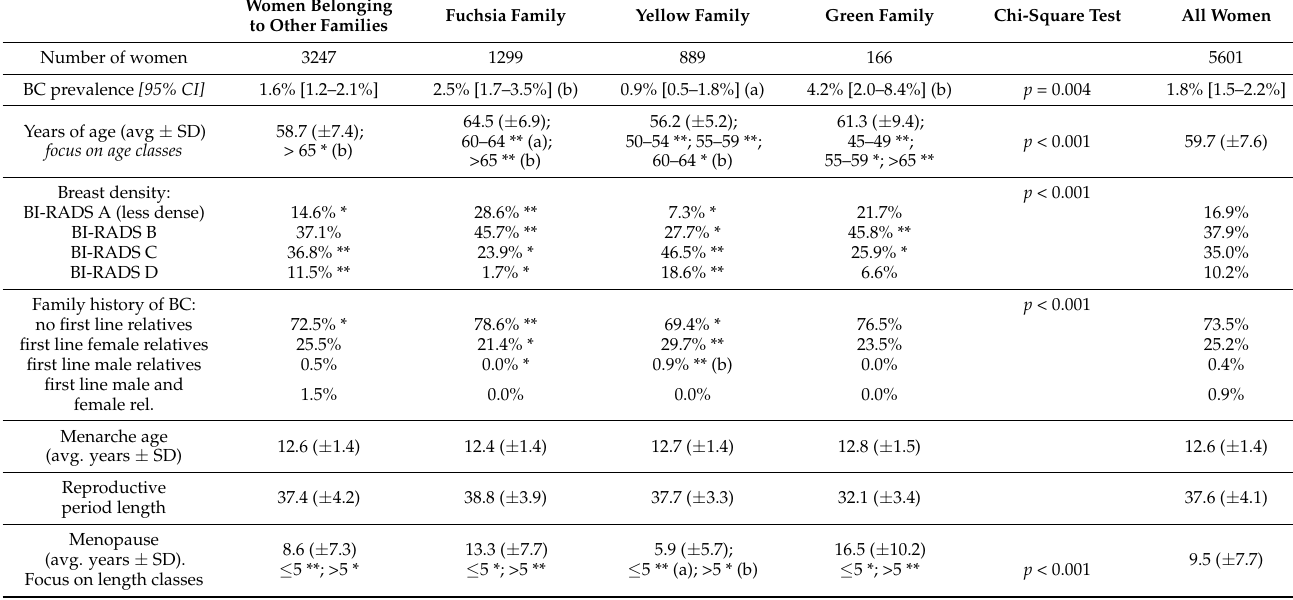
Table 1. Distribution of the characteristics included in the profile 1: overall population of women and focus on the families of community combinations statistically associated with BC. See Section 3.4 for the description of the communities and the